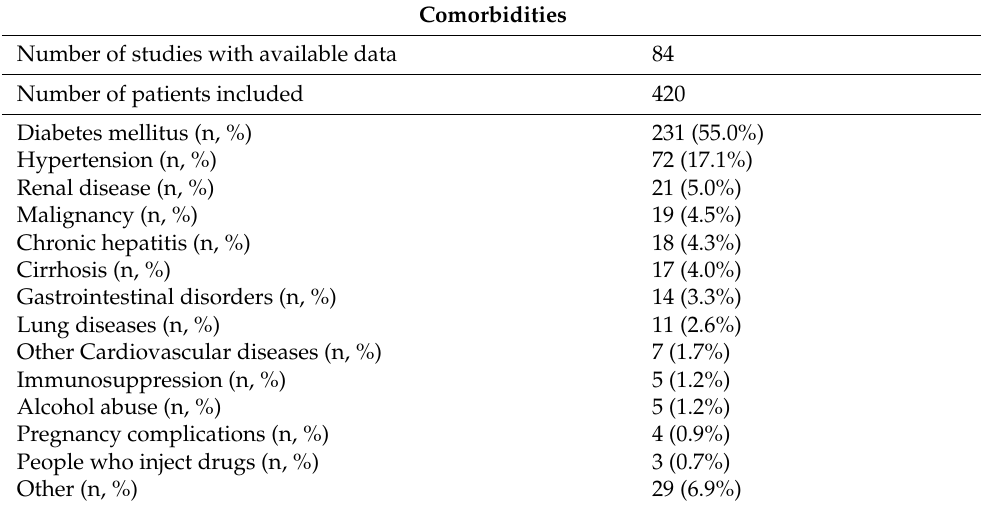
Table 2. Comorbidities in the selected population.